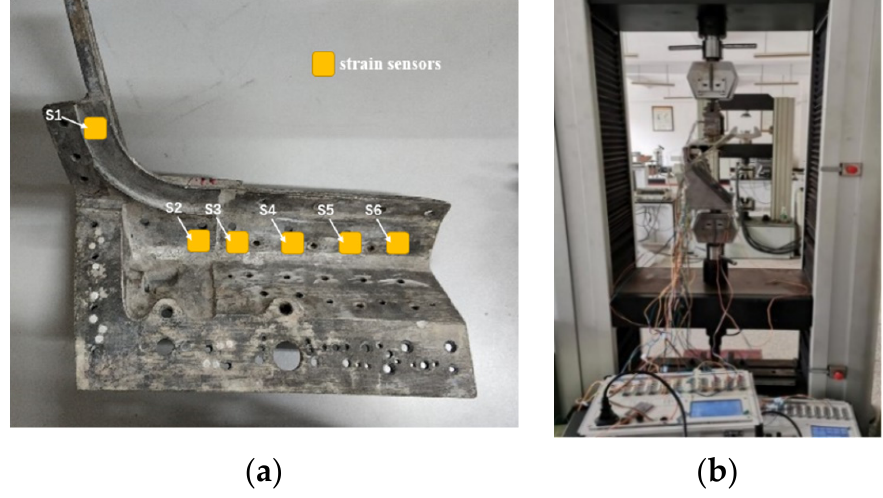
controlled electronic universal testing machine (WDW-100E), a static strain test and analysis system (TST3822EN), and a strain gauge sensor (BA120-3AA150 (16)-G1K-JQC). The final test assembly is shown in Figure 7b.